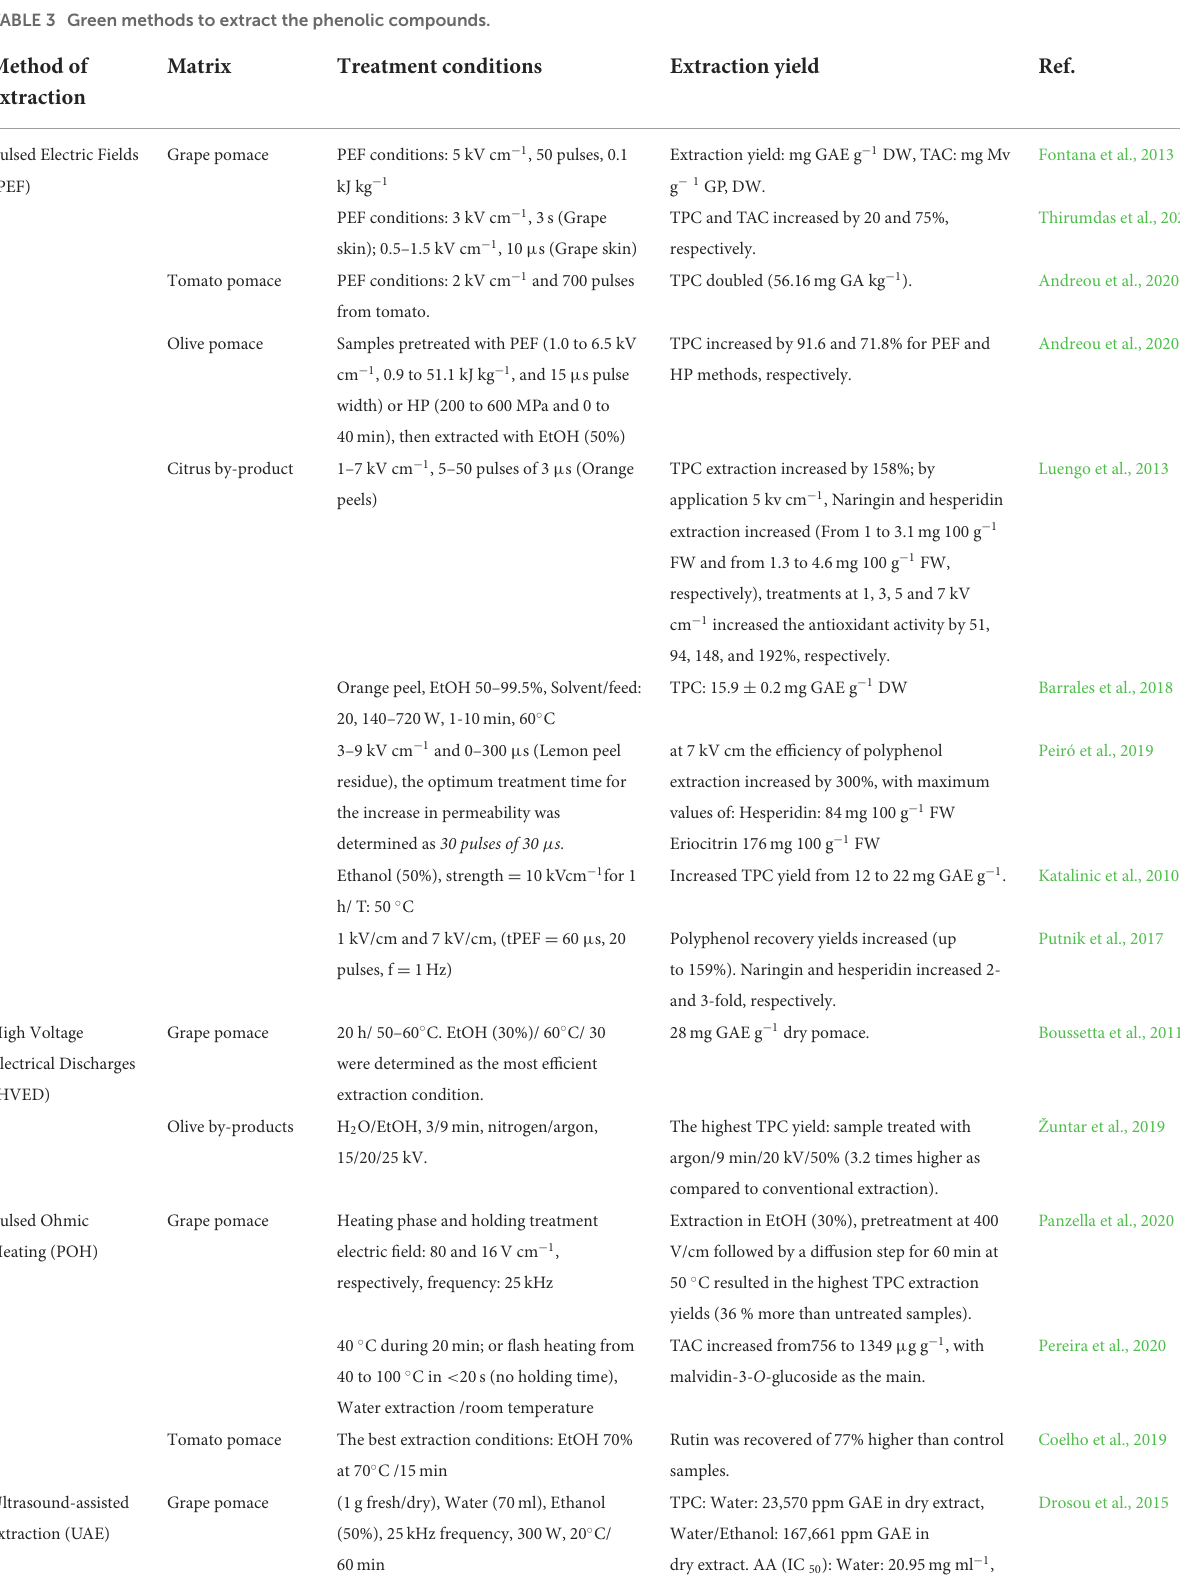
TABLE 3 Green methods to extract the phenolic compounds. Method of